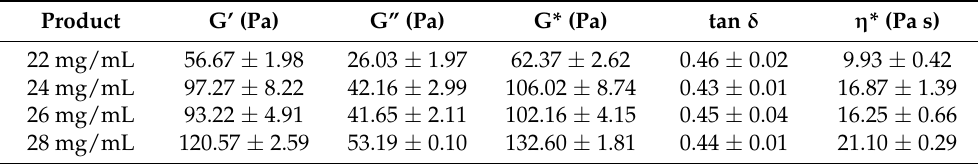
Table 2. Rheological data of four HA hydrogel dermal fillers, provided by Matex Lab S.p.A., character- ized with respect to their Linear Viscoelastic Region (LVER) at temperature of 25 ◦ C and at a shear strain value of 1%. Data are presented as averages and relative standard deviation percentage (RSD %).